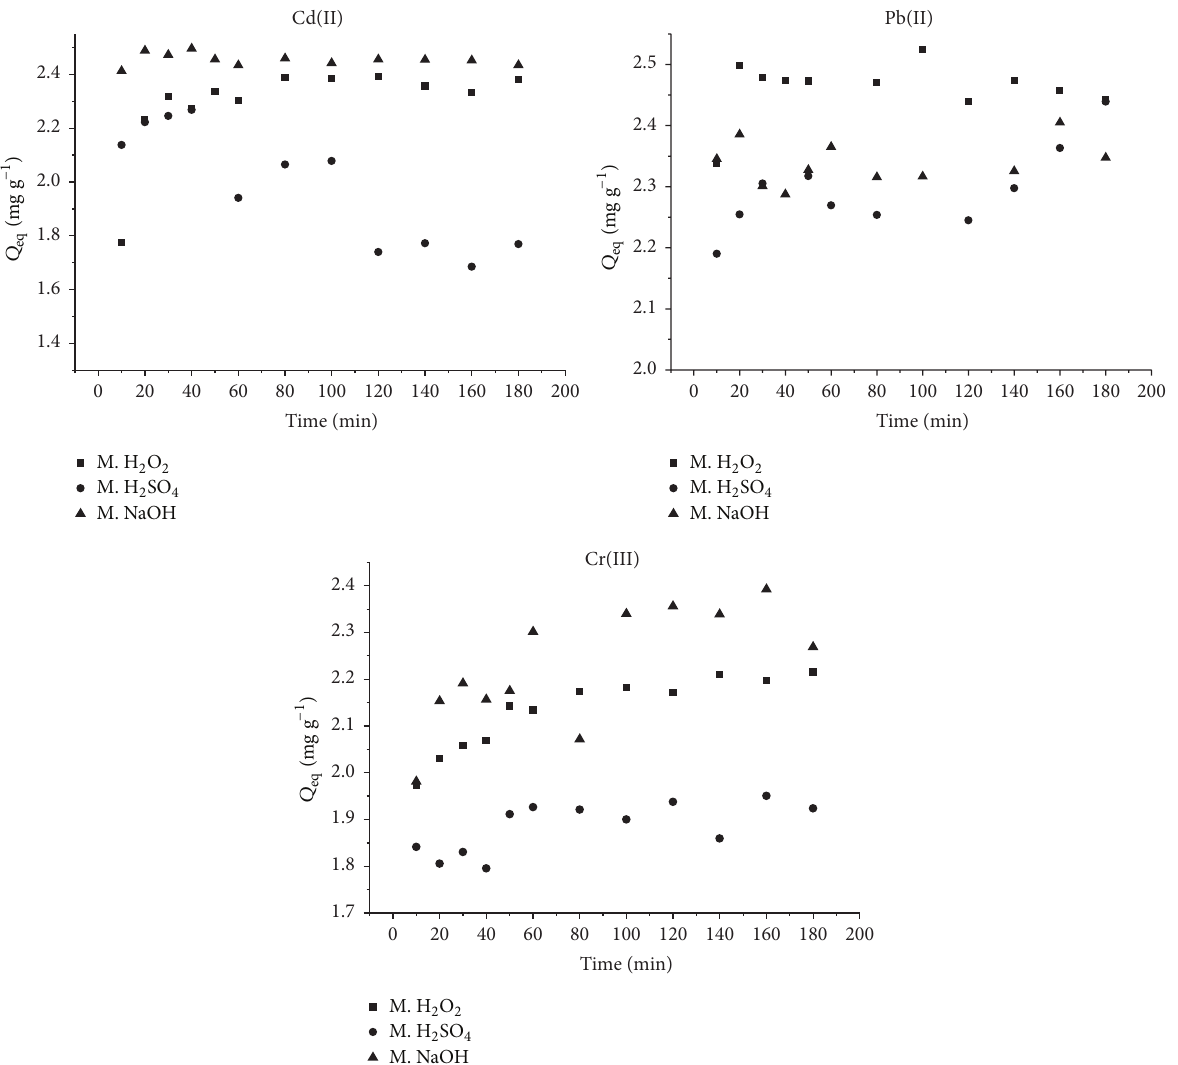
Figure 3: Physical-chemical equilibrium time between modified adsorbents and mono-elementary solutions of Cd(II), Pb(II), and Cr(III).